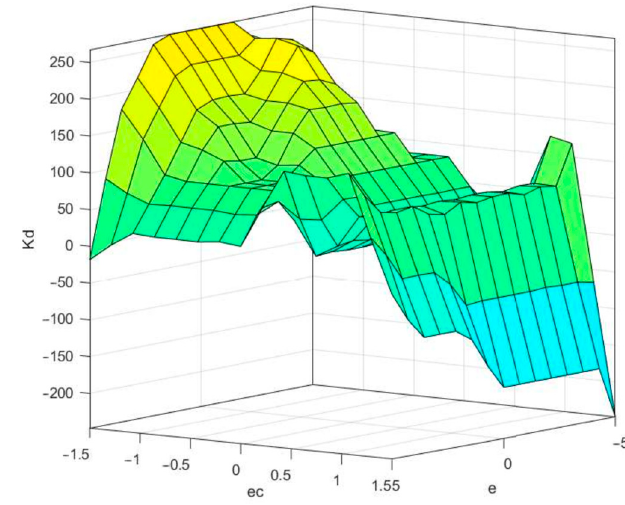
Figure 5. Fuzzy turner surface of ∆ K D .